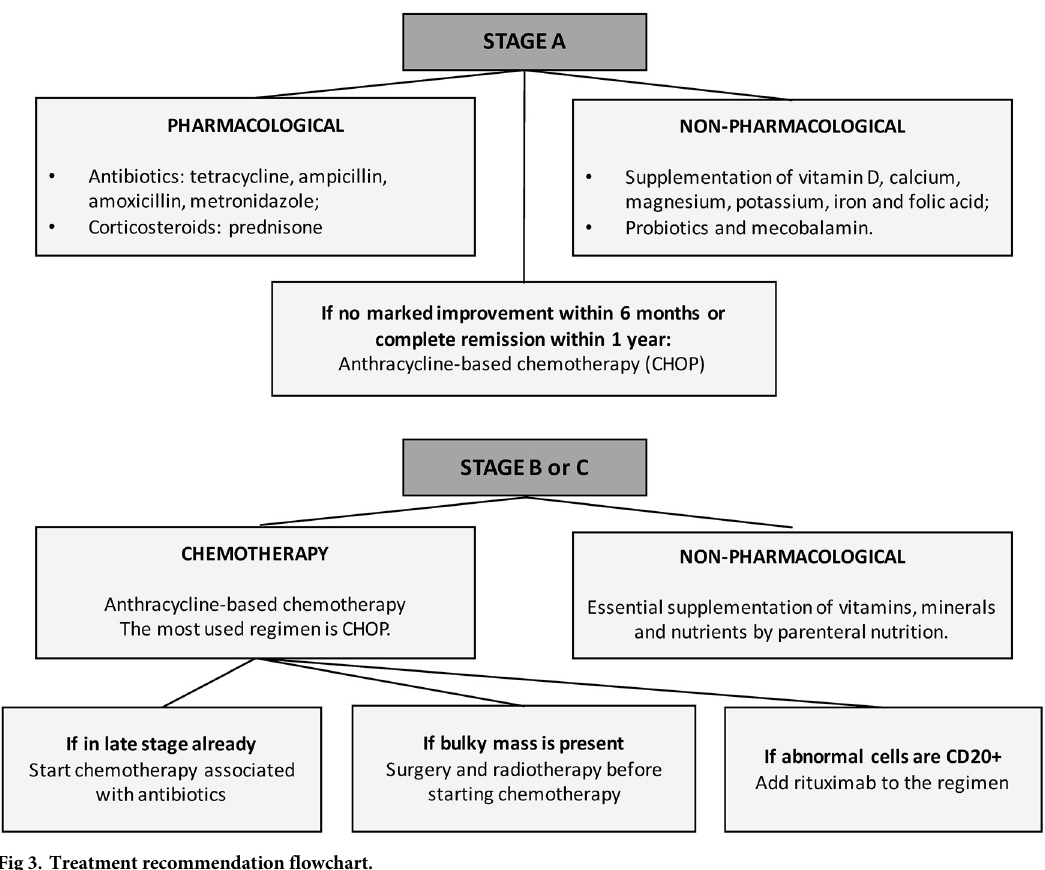
Fig 3. Treatment recommendation